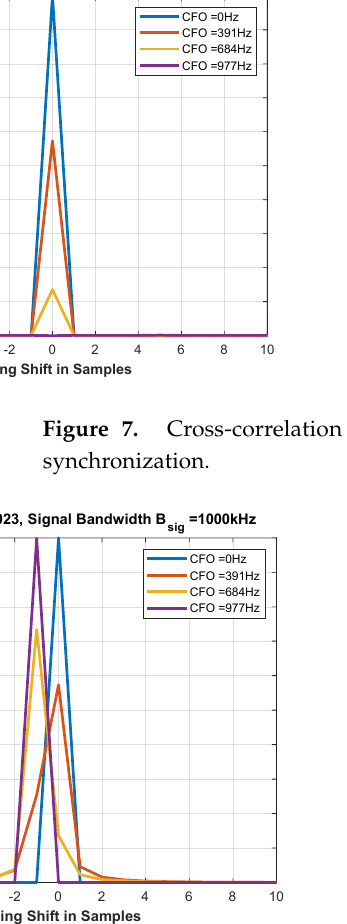
Table 3. Downlink Beacon Sync Fields.